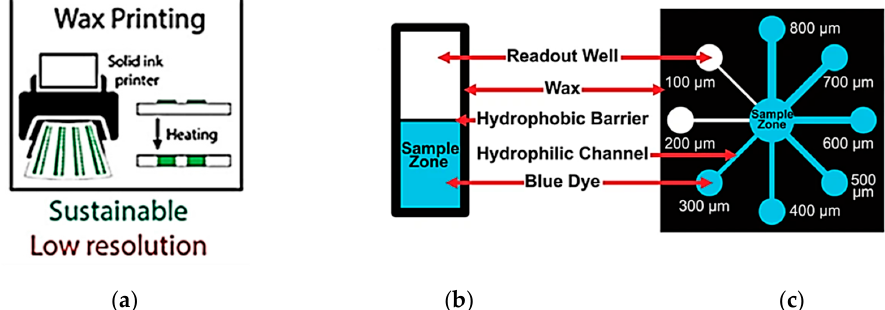
Figure 2. ( a ) Wax patterning on a paper substrate, followed by heating step, to create hydrophobic borders across the substrate. ( b ) A typical example of a μ PAD device for the minimum hydrophobic barrier test. Black boundaries show printed wax which prevents liquid to flow out of channel. ( c ) A paper ‐ based device with multichannel system of various widths (adapted with the permission from